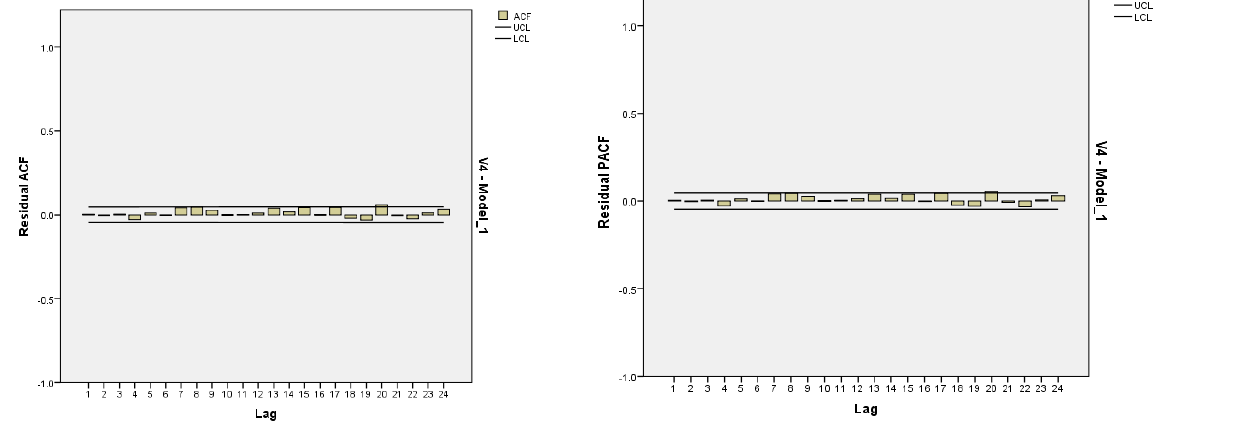
Figure 2. The differentiated partial auto-correlation